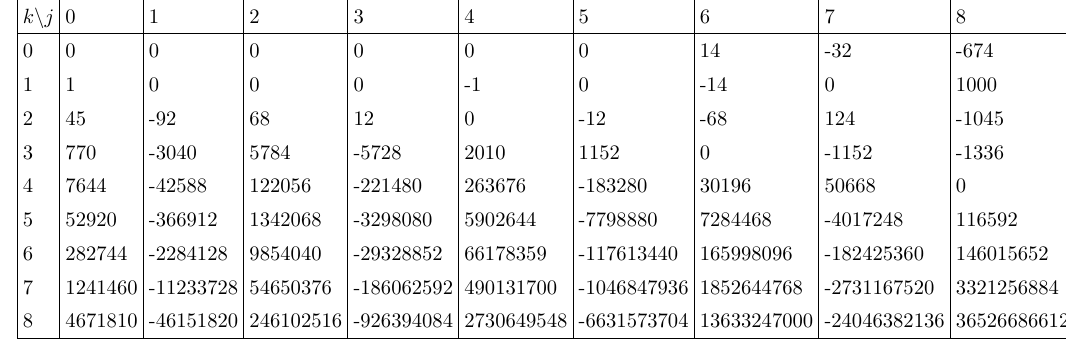
Table 67. Table of b jk coe(cid:14)cients for h SO(10)